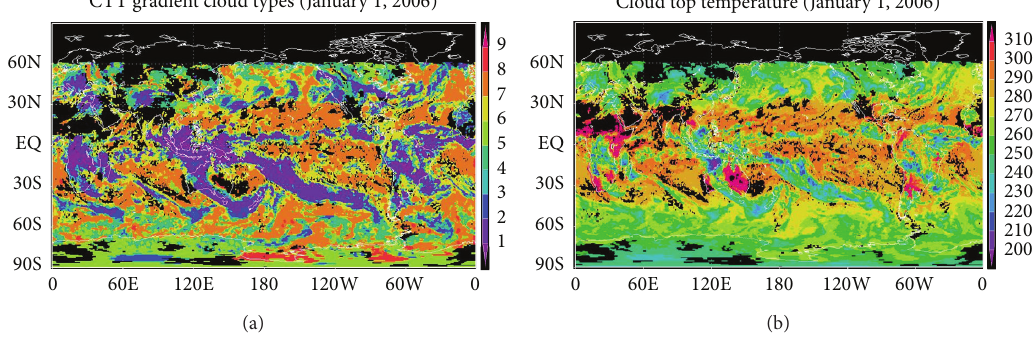
Figure 4: Cloud type classification using the cloud top temperature (CTT) gradient image segmentation algorithm (left) compared to the CTT colored image (in degree-K). 1: cirrus, 2: cirrostratus, 3: deep convection, 4: altocumulus, 5: altostratus, 6: nimbostratus, 7: cumulus, 8: stratocumulus, and 9: stratus.